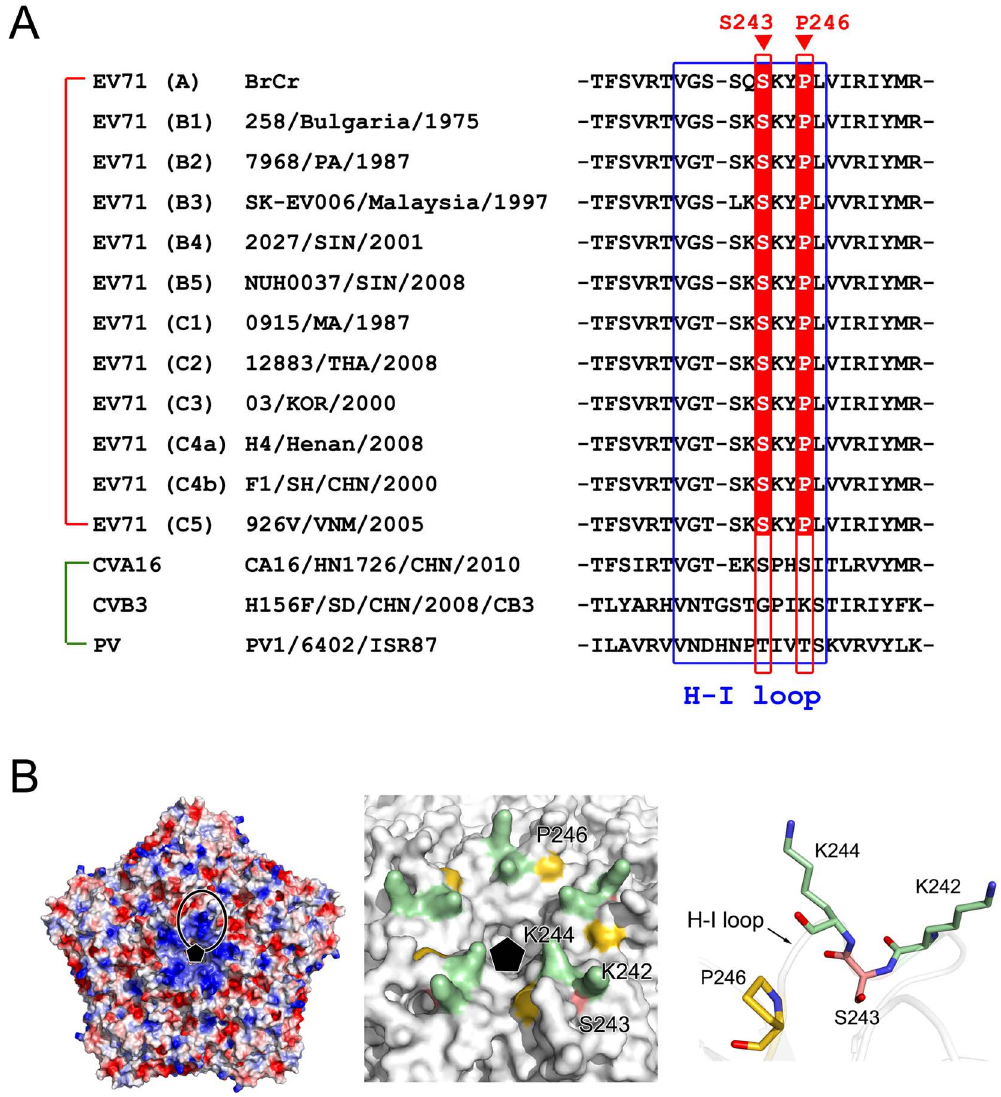
Figure7. Theactivesite of CypA in EV71VP1. (A) A sequence comparison of theH-I loop inVP1forthedifferent EV71 strainsCVA16,CVB3,andPV. The H-I loop is indicated by a blue frame. The drug-resistant site (VP1-S243) and the potential CypA functional site (VP1-P266) in the H-I loop of EV71 VP1 are also indicated. (B) The location of the CypA functional site. Left panel, the electrostatic potential surface of five icosahedral asymmetric units (PDB code: 4AED). Negatively charged surfaces are shown in red, and positively charged areas are shown in blue. The H-I loop region was framed out. The fivefold axis is indicated by a black pentamer. In the middle panel, the molecular surfaces are around the fivefold axis of symmetry. VP1-K242 and -K244, VP1-S243, and VP1-P266 are colored green, red and gold, respectively. Right panel, detailed structure of the H-I loop of EV71 VP1-K242 and -K244, VP1- S243, and VP1-P266. The VP1 molecule is drawn as a transparent cartoon, and the specific residues are shown as colored sticks.